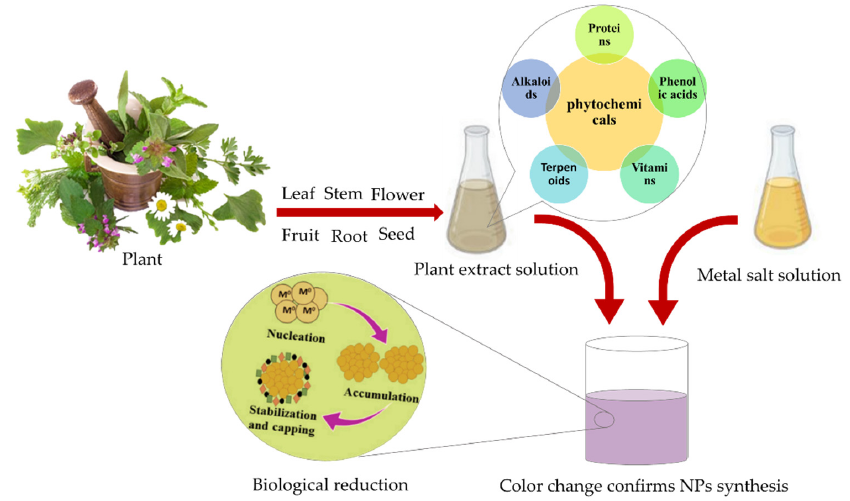
Figure 3. Schematic illustration of biosynthesis of metallic NPs from a plant.